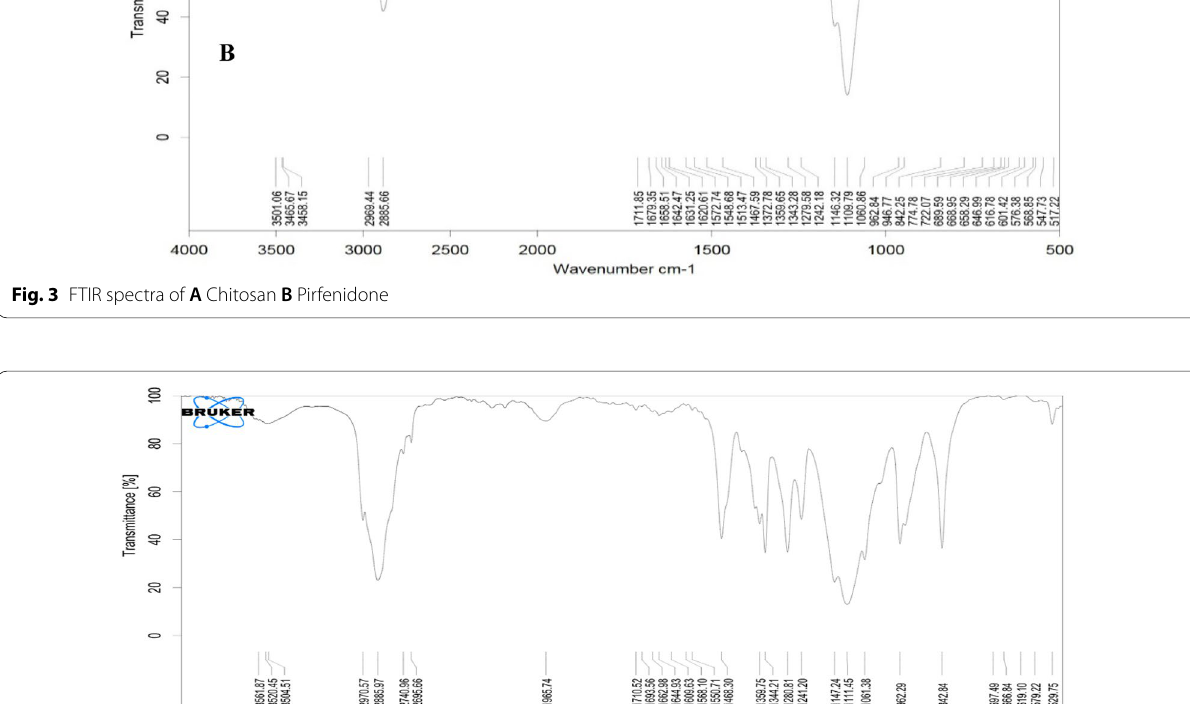
Fig. 4 FTIR study of pirfenidone loaded chitosan nanoparticles (optimized